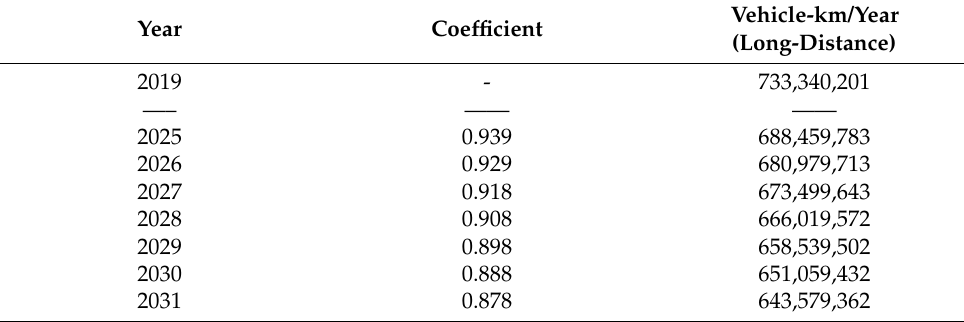
Table 6. Estimated vehicle-km/year on long distances between 2025 and 2040